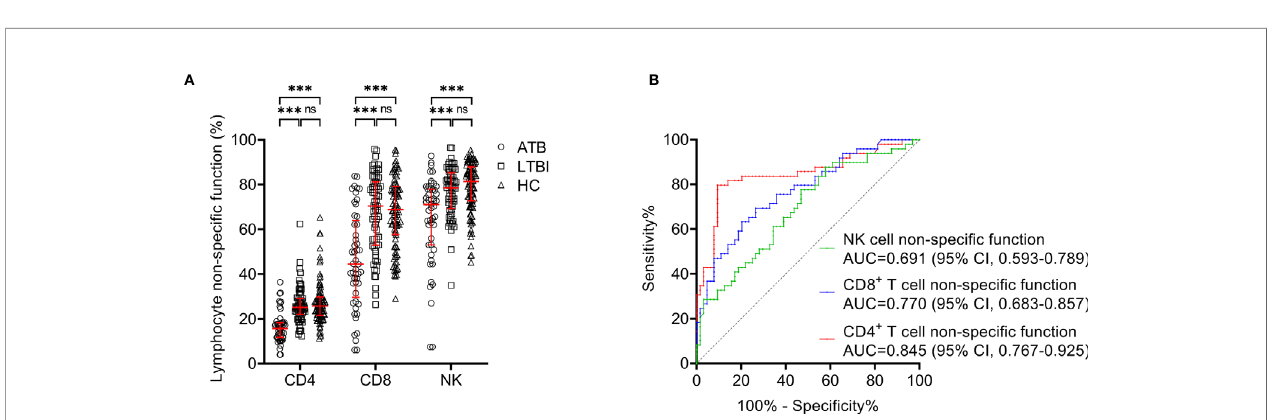
FIGURE 3 | Lymphocyte non-speci fi c function detection for distinguishing between ATB and LTBI. (A) Scatter plots showing the results of CD4 + T cell non-speci fi c function, CD8 + T cell non-speci fi c function, and NK cell non-speci fi c function in ATB patients (n=49), LTBI individuals (n=64), and HC (n=95). Bars indicated the medians and interquartile ranges. *** P < 0.001; ns, no signi fi cance (Mann-Whitney U test). (B) ROC analysis showing the performance of CD4 + T cell non-speci fi c function, CD8 + T cell non-speci fi c function, and NK cell non-speci fi c function in discriminating ATB patients from LTBI individuals. ATB, active tuberculosis; LTBI, latent tuberculosis infection; HC, healthy controls; ROC, receiver operating characteristic; AUC, area under the curve; CI, con fi dence